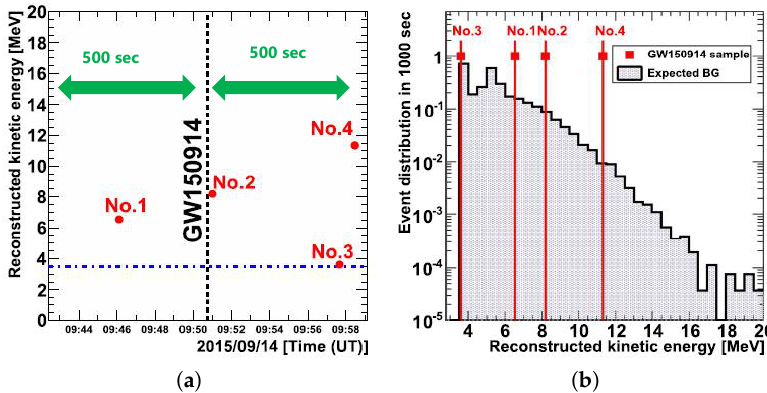
Figure 1. ( a ) The timing distribution within the ± 500-s time window around GW150914. ( b ) The energy distribution of the observed events (red points) within ± 500 s together with the expected background (gray histogram). The original figures were adopted from [22].